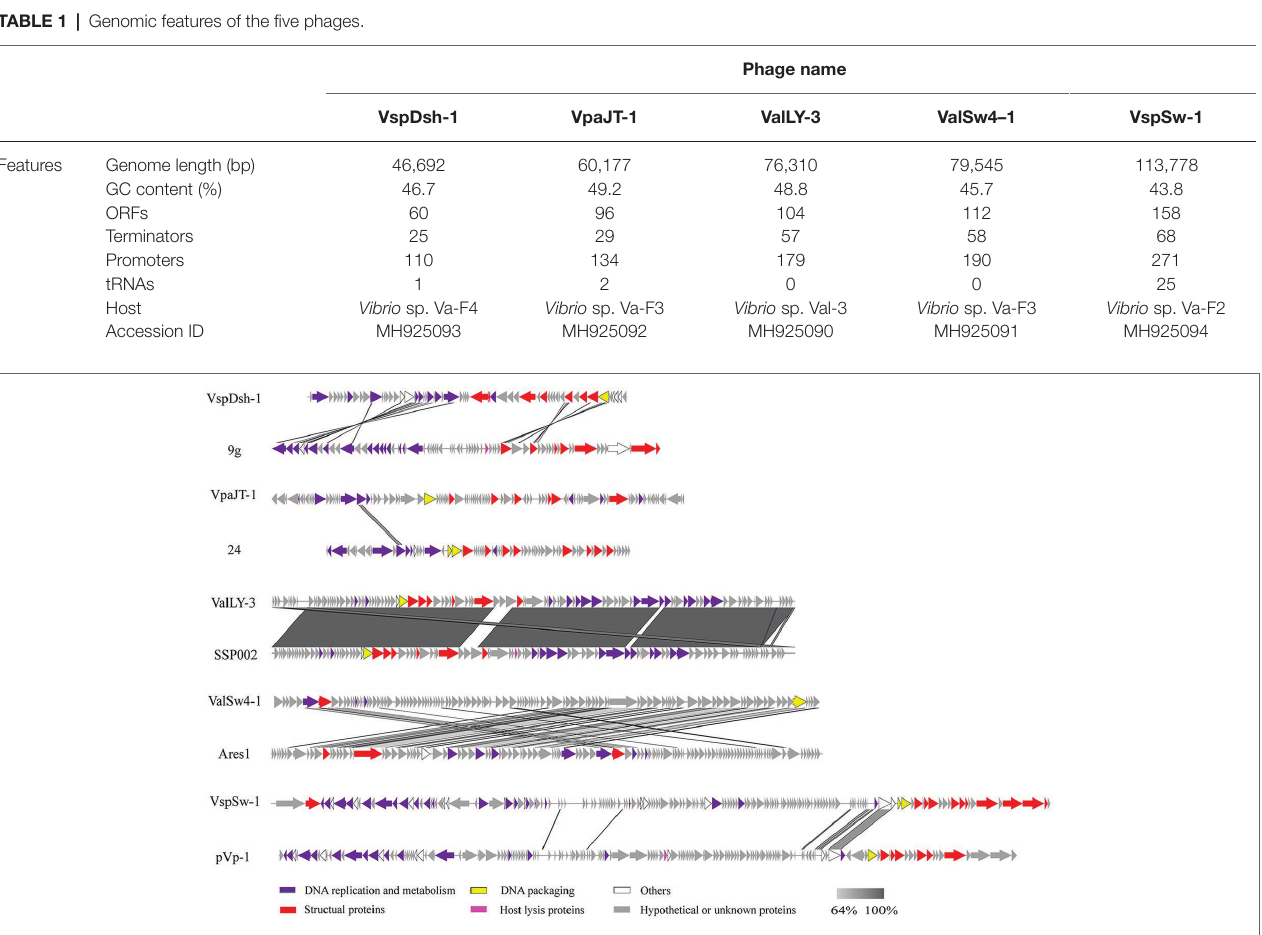
FIGURE 4 | Multiple sequence alignment of phage genomes. Whole genome sequences of the isolated phages (ValLY-3, VspDsh-1, VpaJT-1, ValSw4-1, and VspSw-1) and the highest similar reference phages were compared using Easyfig. The gray regions indicate high similarity among the genomic sequences. The predicted functional proteins are indicated by different colors. Blastn analyzes of the five phages’ genomes show that the top hits in NCBI nr database of ValLY-3, VspDsh-1, VpaJT-1, ValSw4-1, and VspSw-1 are Vibrio phage SSP002 (JQ692107.1, with cover 95% and identity 99%), Enterobacteria phage 9 g (KJ419279.1, with cover 0% and identity 80%), vB_SenS_Sergei (KY002061.1, with cover 0% and identity 100%), Vibrio phage Ares1 (MG720309.1, with cover 31% and identity 67%), and Vibrio phage pVp-1 (JQ340389.1, with cover 2% and identity 79%),